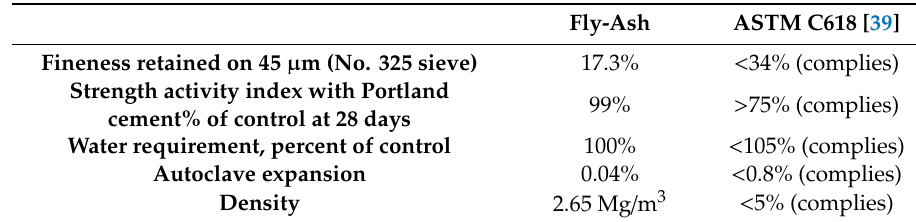
Table 2. Fly-ash physical properties.